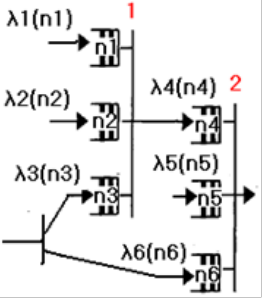
Figure 8. The two synchronization stations of a stage of an Extended Kanban